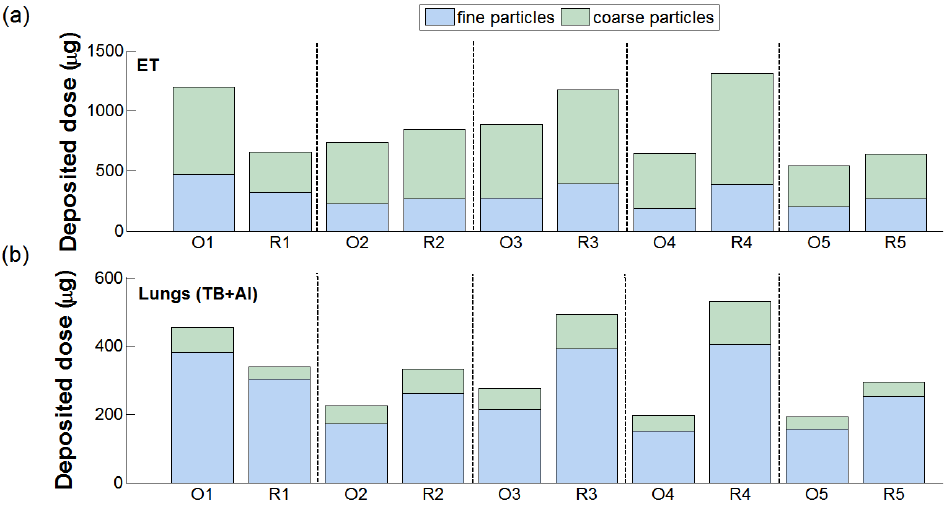
Figure 2. Weekly (5-days) deposited dose of fine (PM 2.5 ) and coarse (PM 2.5–10 ) particles at the ( a ) ET and ( b ) lungs (TB + AI) regions of 10-year-old children (O1–O5: Outdoor exposure scenario, R1–R5: Realistic exposure scenario).